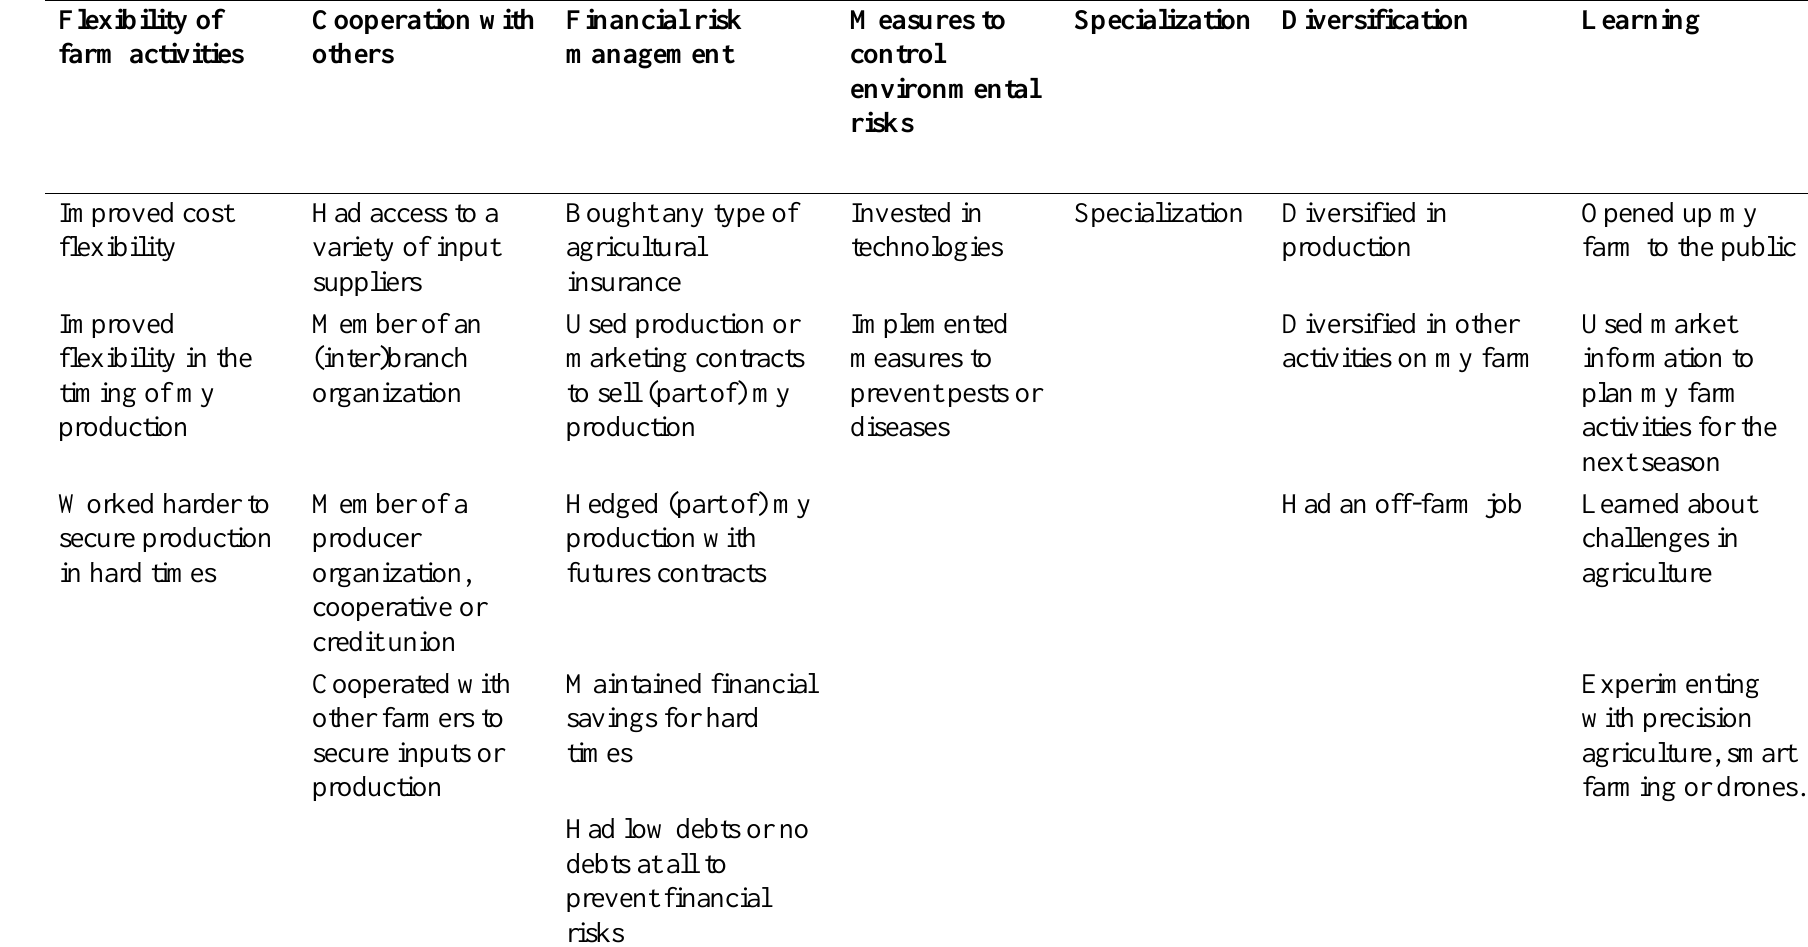
Table A1 . 1 Overview of risk management strategies included in the survey Flexibility